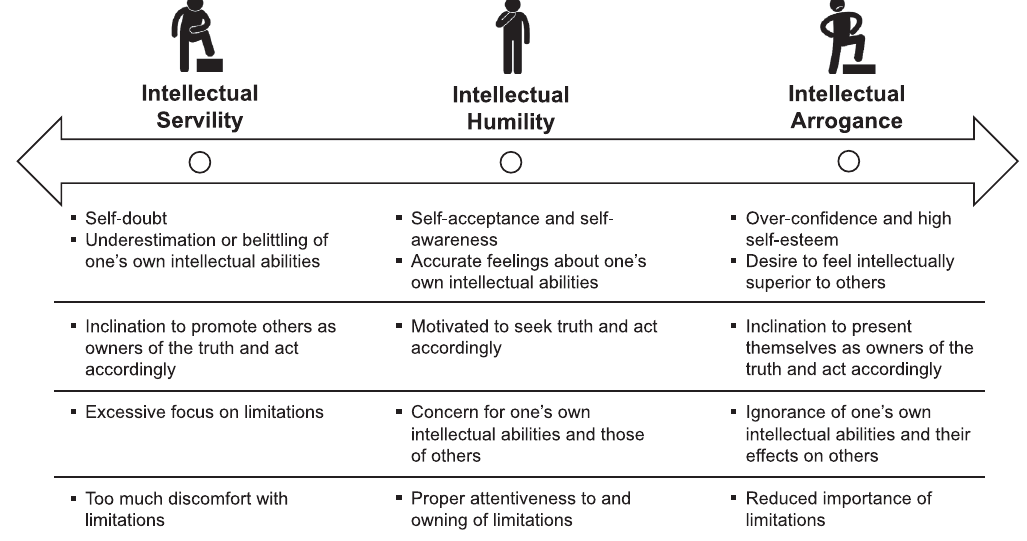
FIG. 1. Spectrum illustrating the characteristics of and relationship between intellectual humility and two extreme constructs: Intellectual servility and intellectual